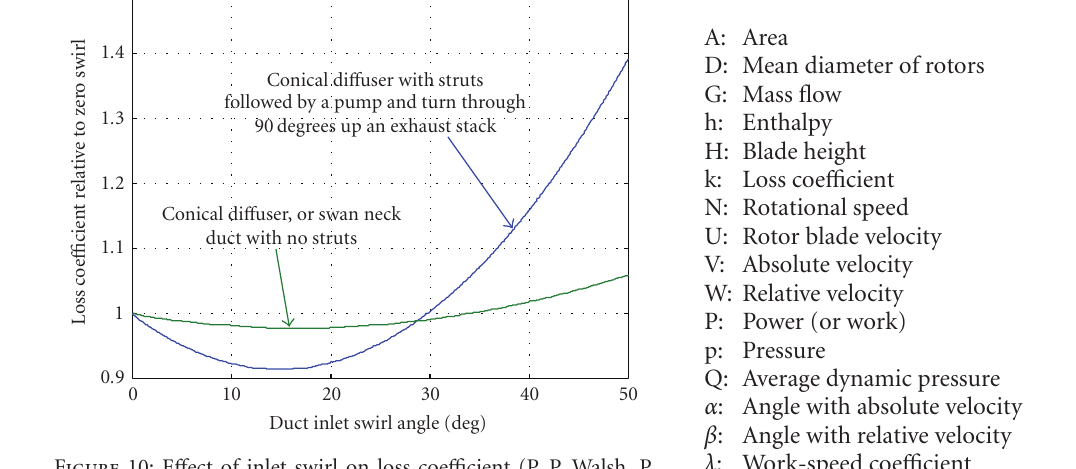
Figure 10: E ff ect of inlet swirl on loss coe ffi cient (P. P. Walsh, P. Fletcher, Gas Turbine Performance ).